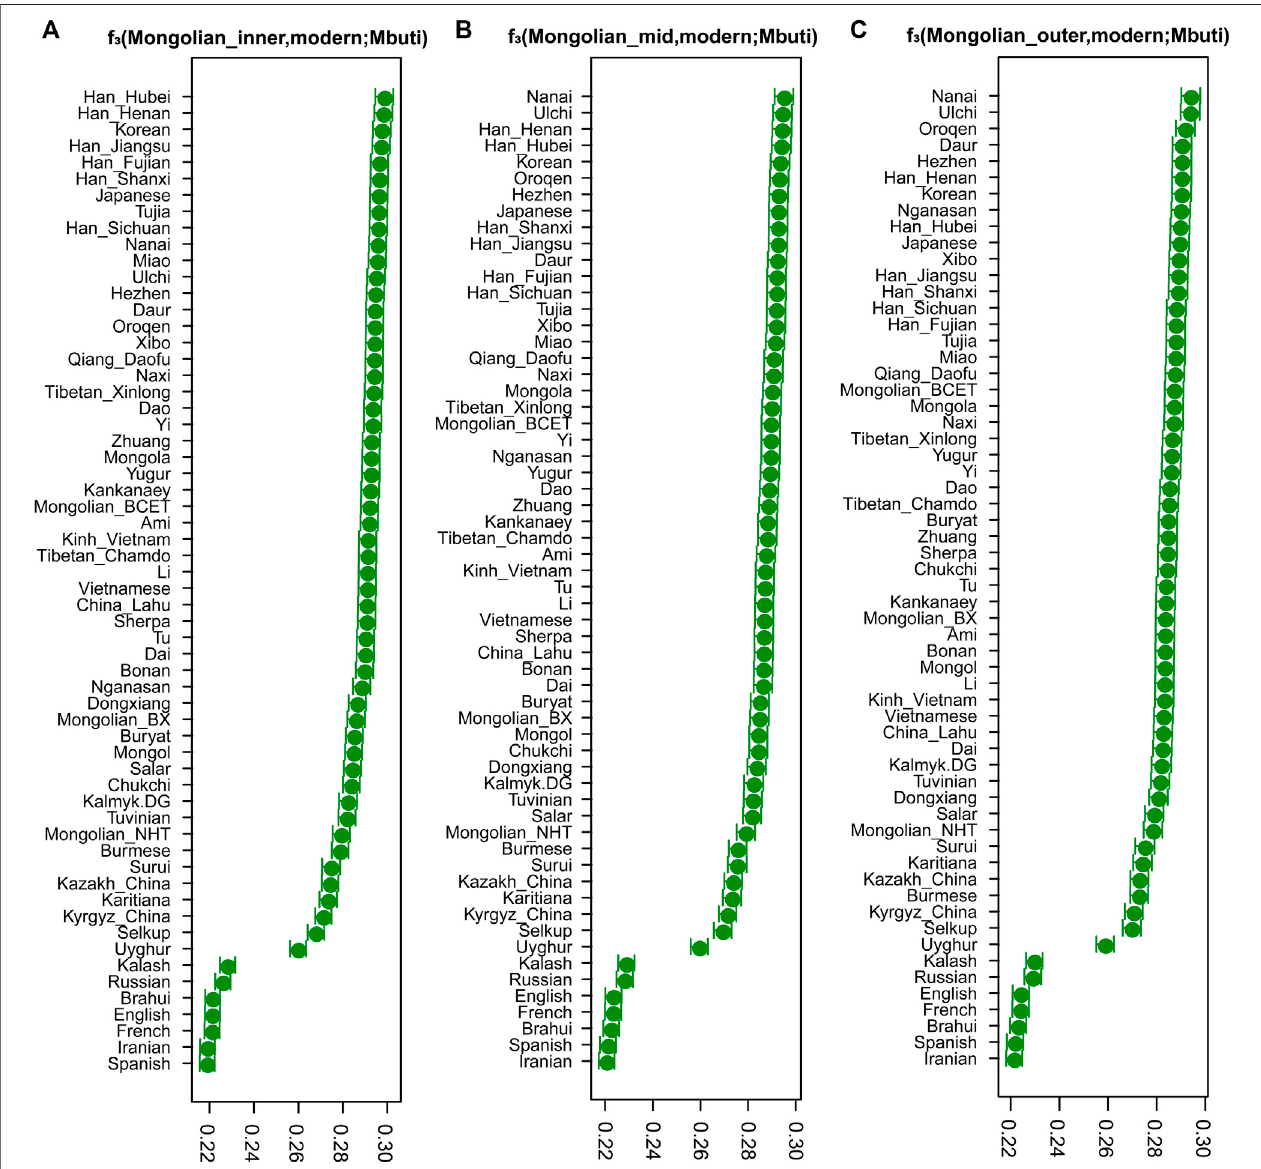
FIGURE 2 | The results of three-population statistic. The shared genetic drift between modern Eurasian populations and Mongolian subgroups.